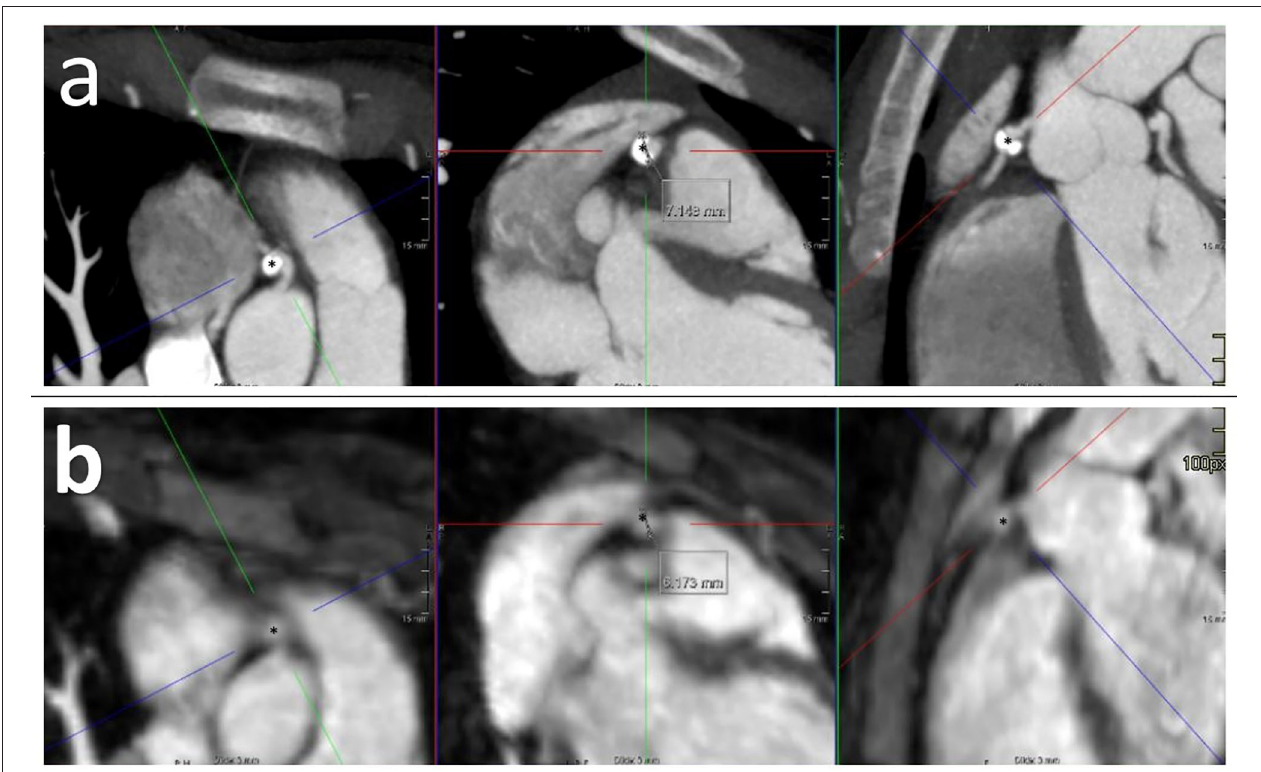
FIGURE 1 | cCTA imaging (a) and CMR imaging (b) of KD patient with near giant CAA (*) in RCA. Calcification and partial coronary artery thrombus are only visible upon